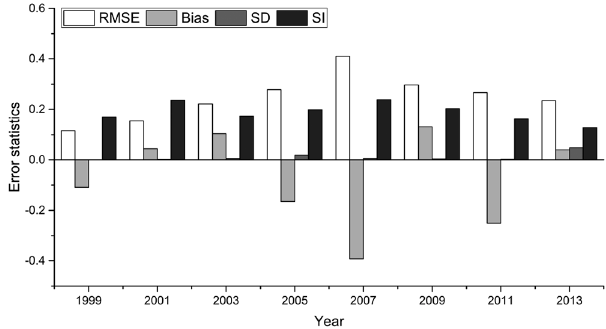
Figure 4. The error indicators in the normal days (1999–2013).